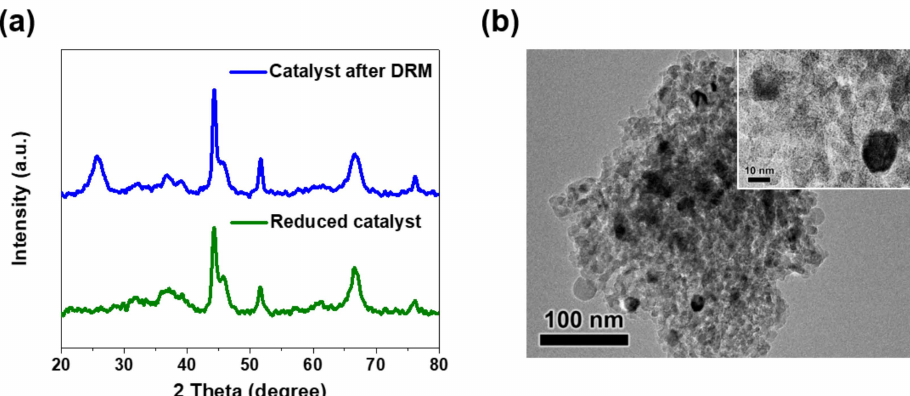
Figure 5. ( a ) X-ray diffraction (XRD) patterns of the reduced catalyst and the catalyst after DRM, ( b ) Transmission Electron Microscopy (TEM) images of the catalyst after DRM.